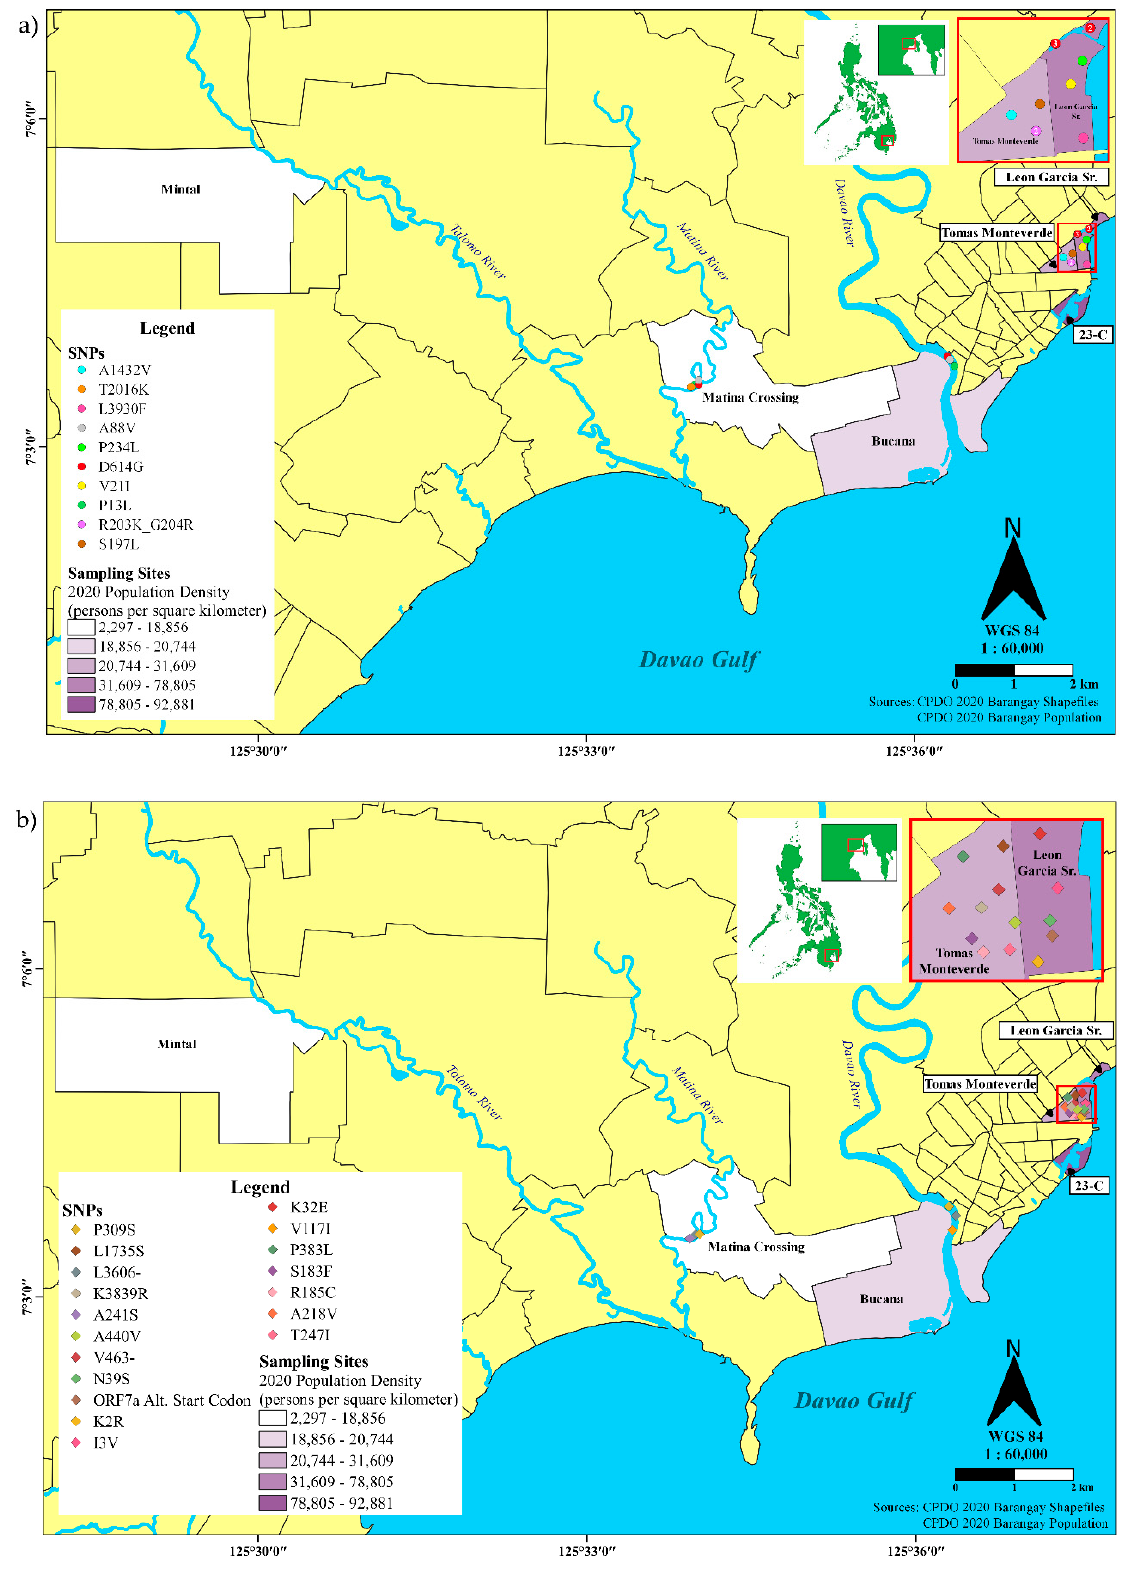
Figure 5. Geographic distribution of SARS-CoV-2 SNPs detected in wastewaters of Davao City, Philippines on November-December 2020 that have been ( a ) previously reported, or ( b ) unreported from clinical cases in GISAID or literature.